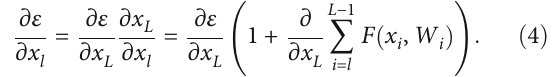
Figure 2; let H ð x Þ = F ð x Þ + x , and then the network only needs to learn to output a residual F ð x Þ = H ð x Þ − x